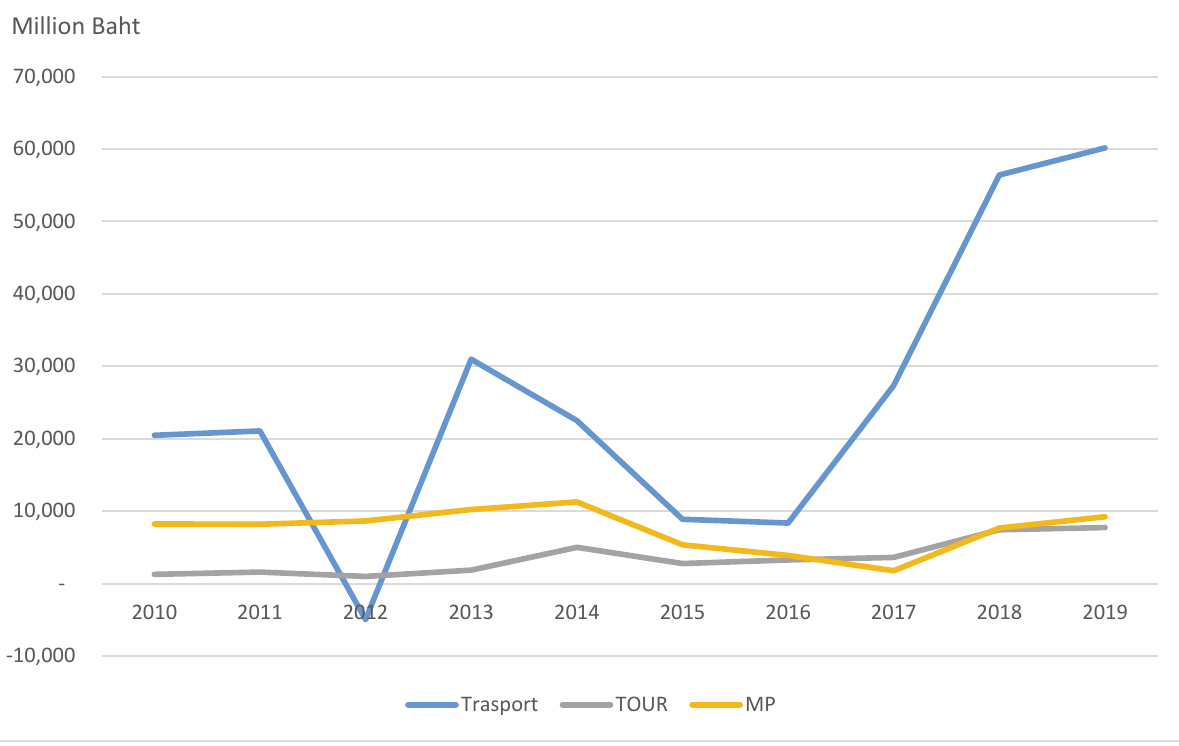
Fig. 3. Value of securities in the transport and service industry category from the Stock Exchange of Thailand from 2010 –